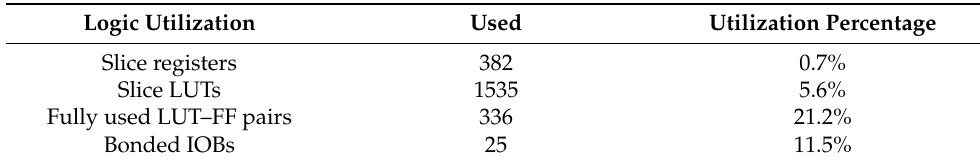
Table 1. Summary of device utilization in FPGA.